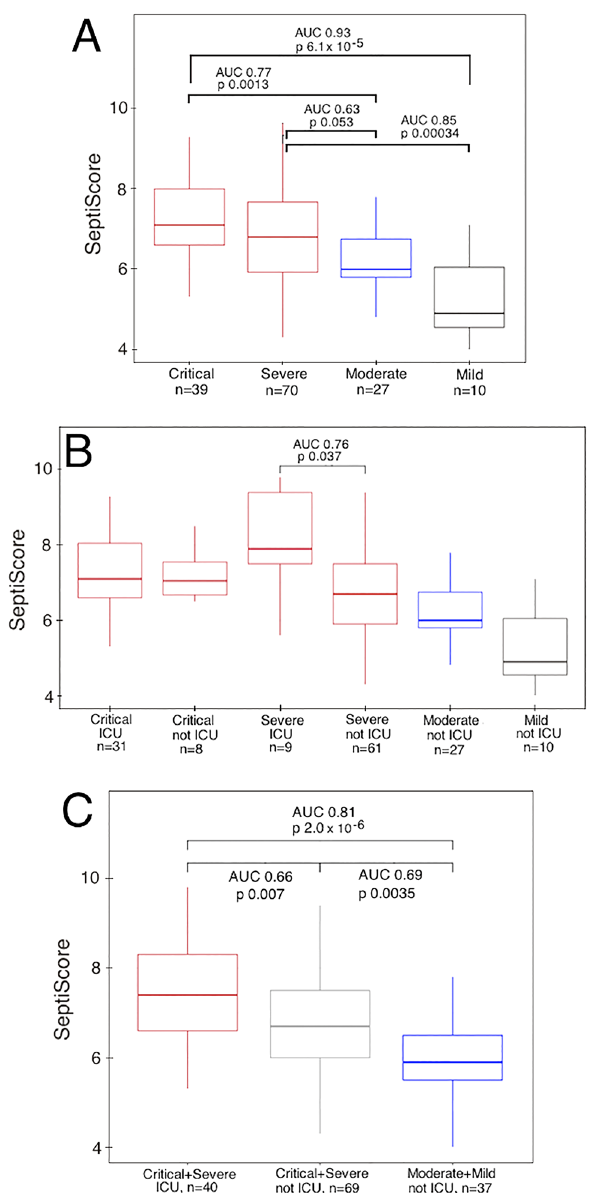
scores across the COVID-19 severity categories, after further stratification by ICU admission vs. non-admission. (C) SeptiCyte RAPID scores for differentiating COVID patients that needed ICU admission from the cases that did not need ICU